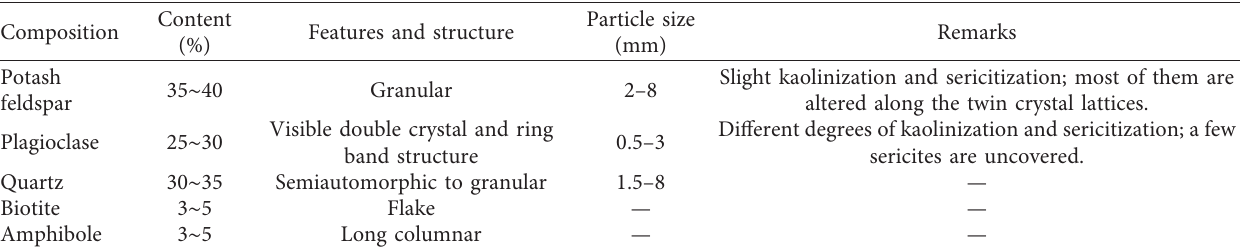
Table 1: Composition and corresponding contents of the granite.